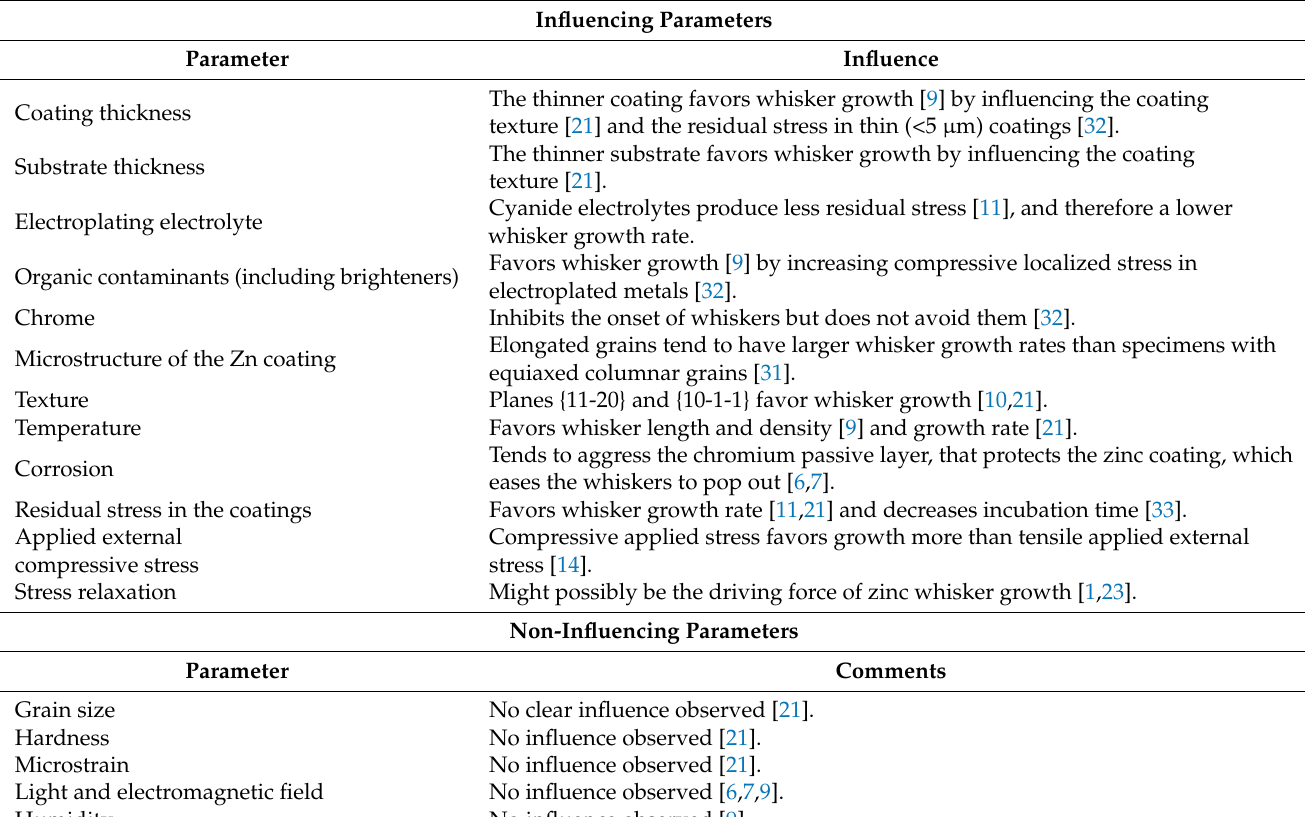
Table 1. Summary of influence of parameters on whiskers